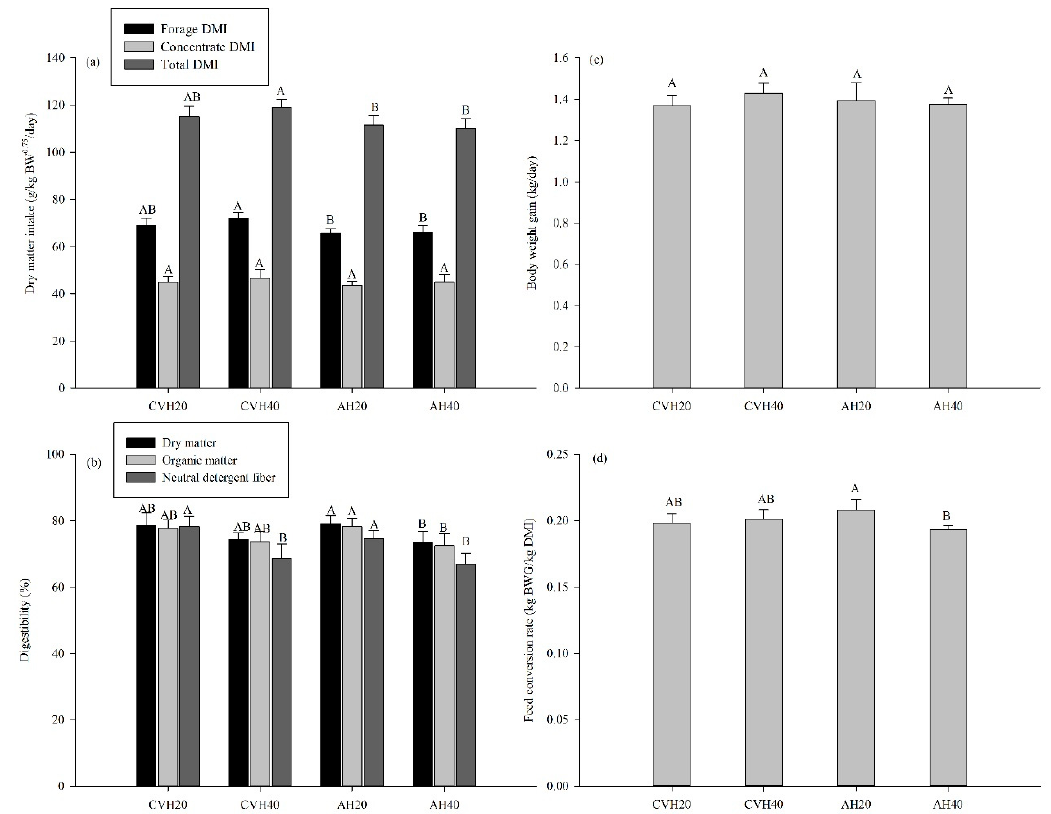
Figure 1. The dry matter intake (DMI) ( a ), digestibility ( b ), body weight gain (BWG) ( c ) and feed conversion rate ( d ) of cattle among the four diet groups. Values are presented as the mean ± standard deviation (SD). Uppercase letters only represent the di ff erence among the four diet